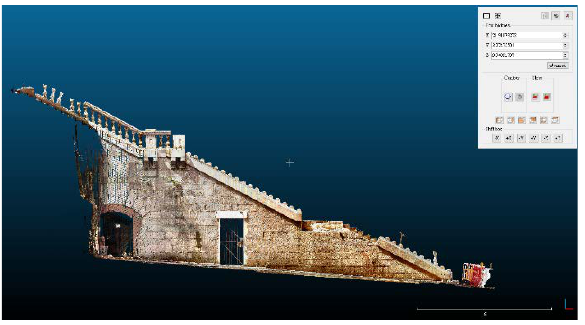
Figure 9: Point cloud of the Steps obtained after damage.